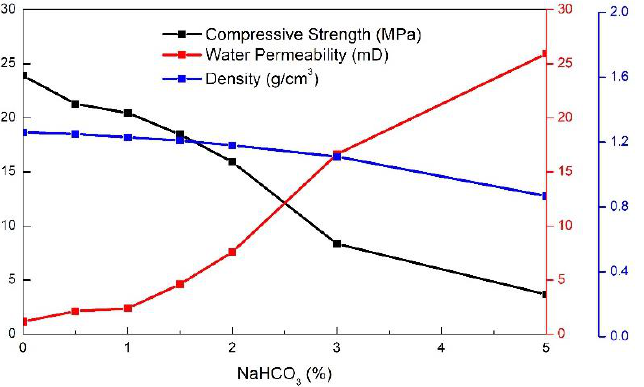
Figure 6. Effect of different mass concentrations of sodium bicarbonate + aluminum sulfate gas- generating system on the performance of cement stone.